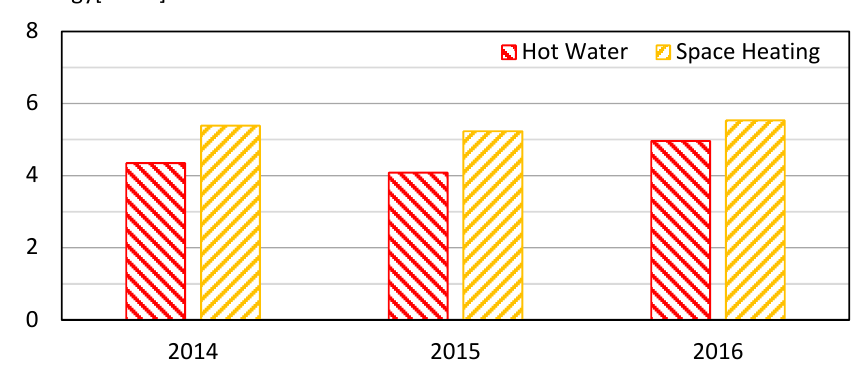
Figure 17. Measured yearly electrical energy consumption of space heating and hot water systems.